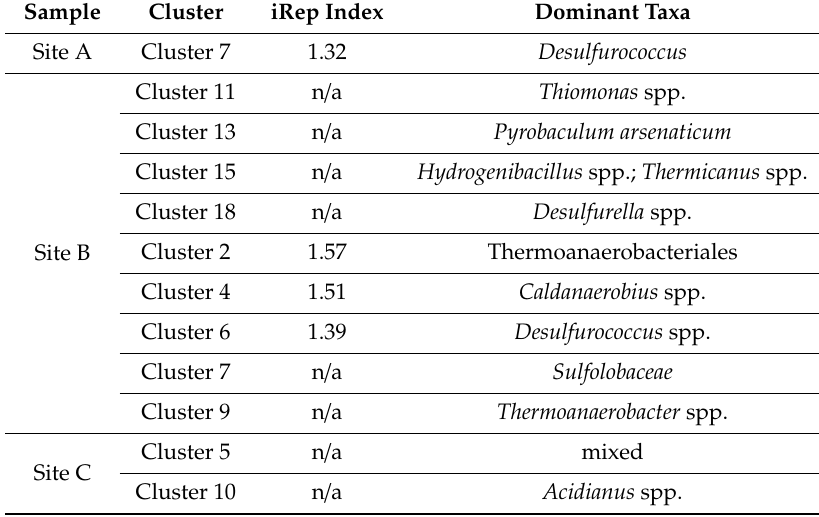
Table 5. iRep indices for validate clusters in sites A, B, and